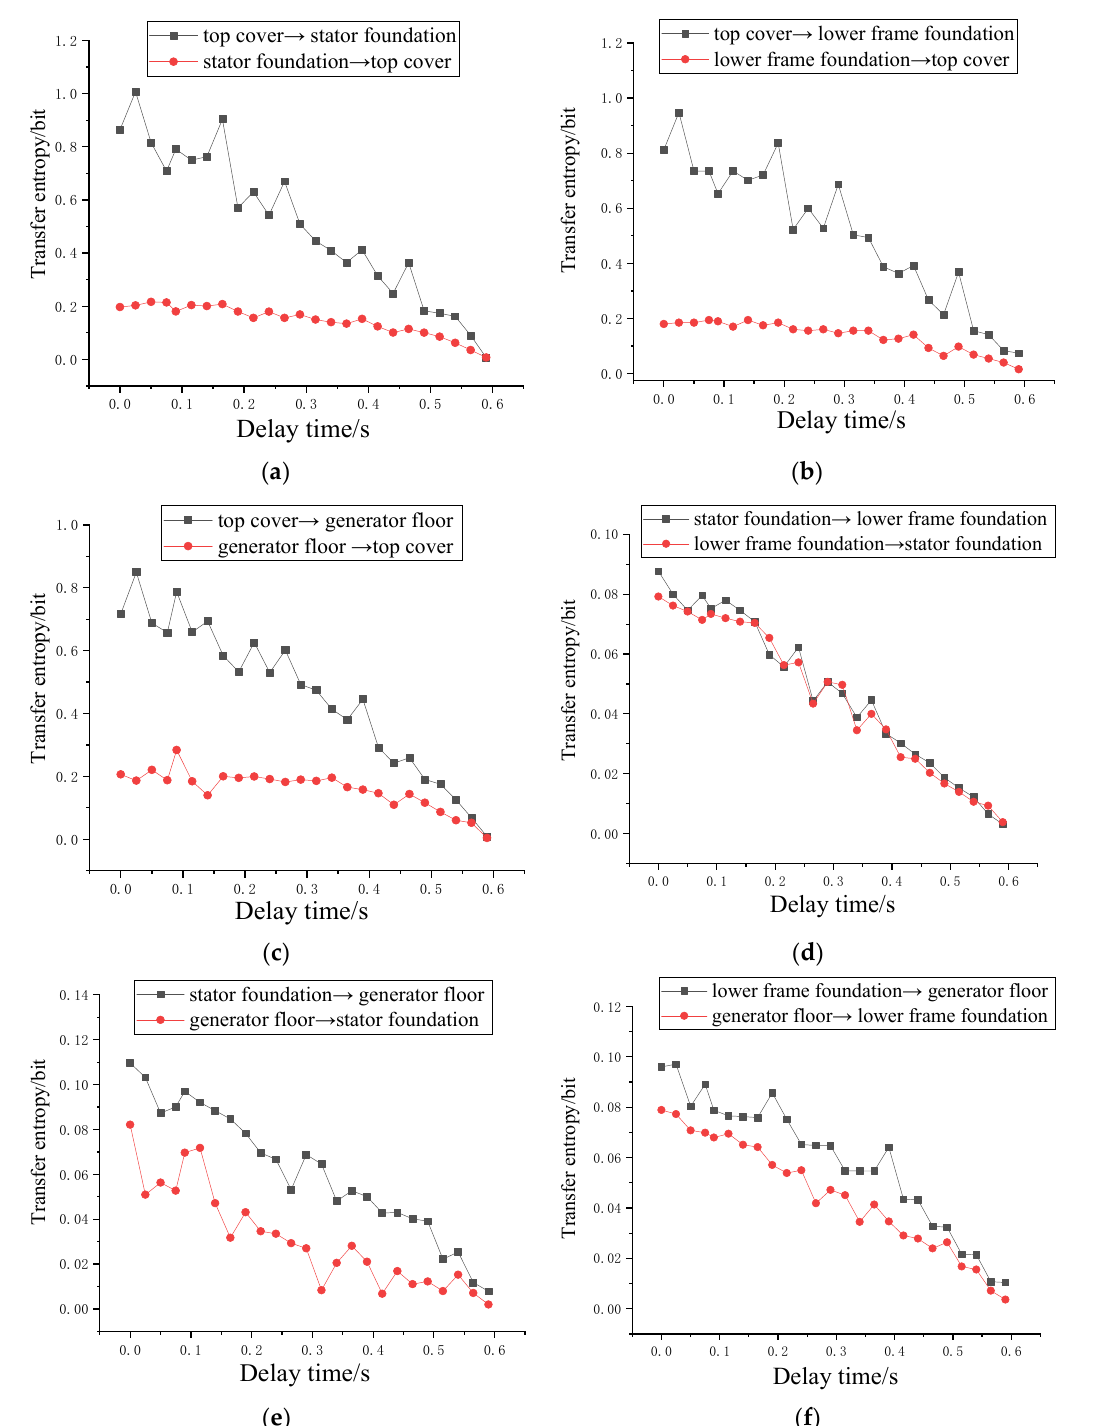
shown in Table 6.